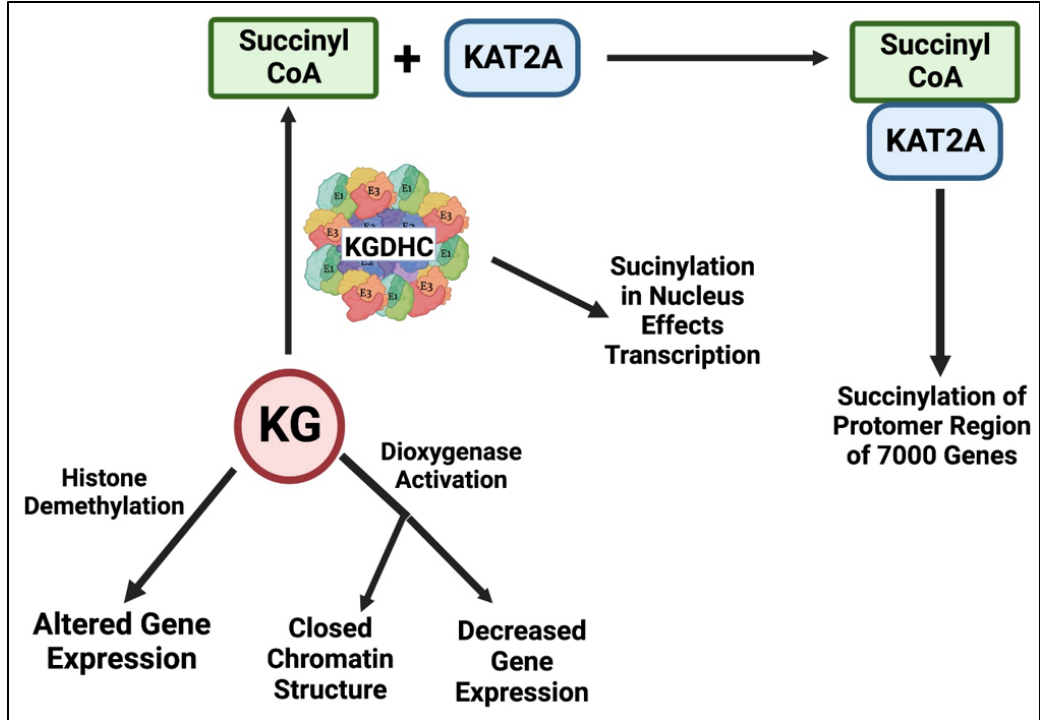
Figure 9. α -ketoglutarate dehydrogenase (KGDHC) and ketoglutarate (KG) in the regulation of transcription. KGDHC mediated succinylation can regulate gene expression by direct succinylation or through the lysine acetyltransferase (KAT2). KG can regulate histone demethylation or dioxygenase activation.